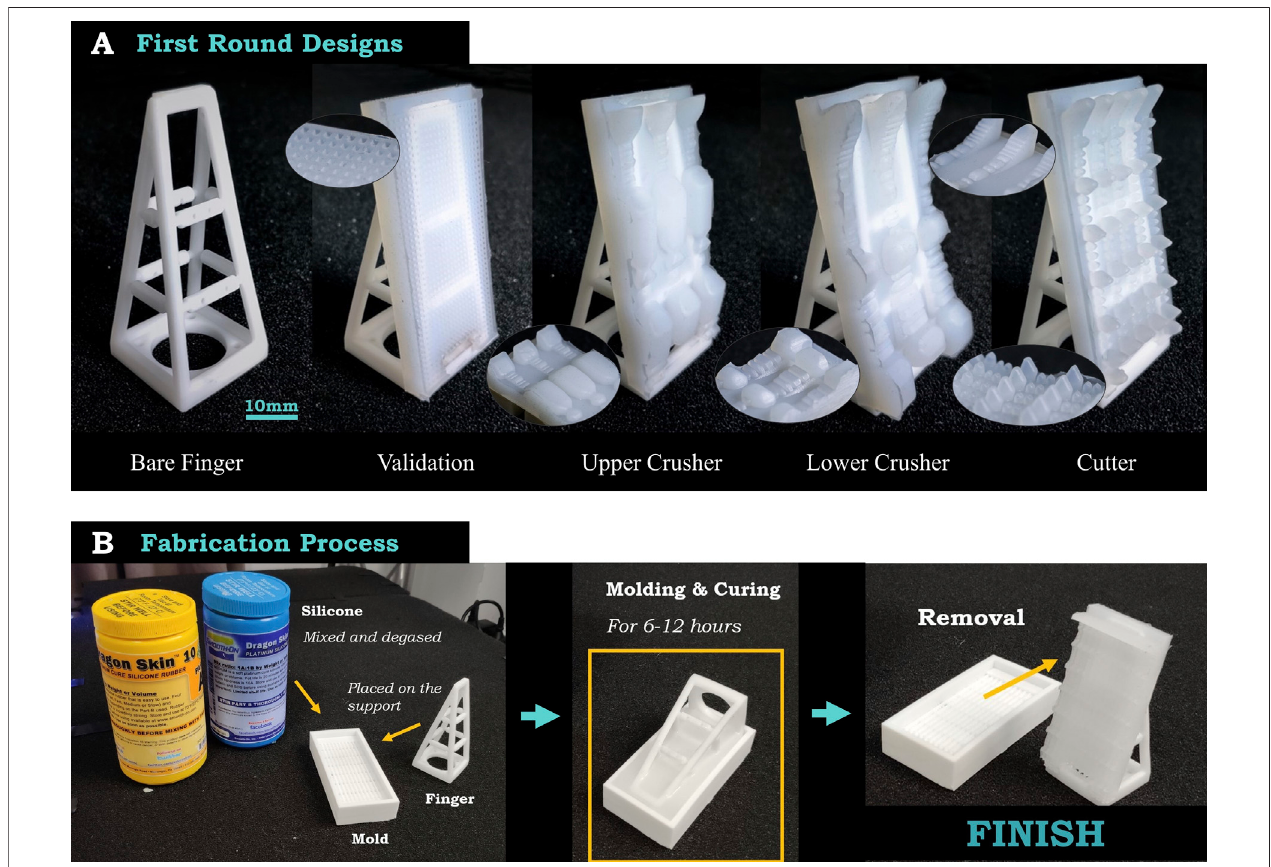
FIGURE 7 | (A) The 5 design candidates tested in the fi rst design iteration round, including 3 initial designs with fi nger surfaces, a bare fi nger design without fi nger surface and a pair of planar validation designs. These initial designs imitate the original shape of the claws of the Boston Lobster, and the validation design is from AUTOLABatUCBerkeleyinarectangularrubberwithmultipletinyvoidsonthesurface. (B) Thefabricationprocesstocombinethemoldedsiliconesurfacetothe fi nger. Images are adapted from Figures 2,3,6 of (Jiang et al., 2021).